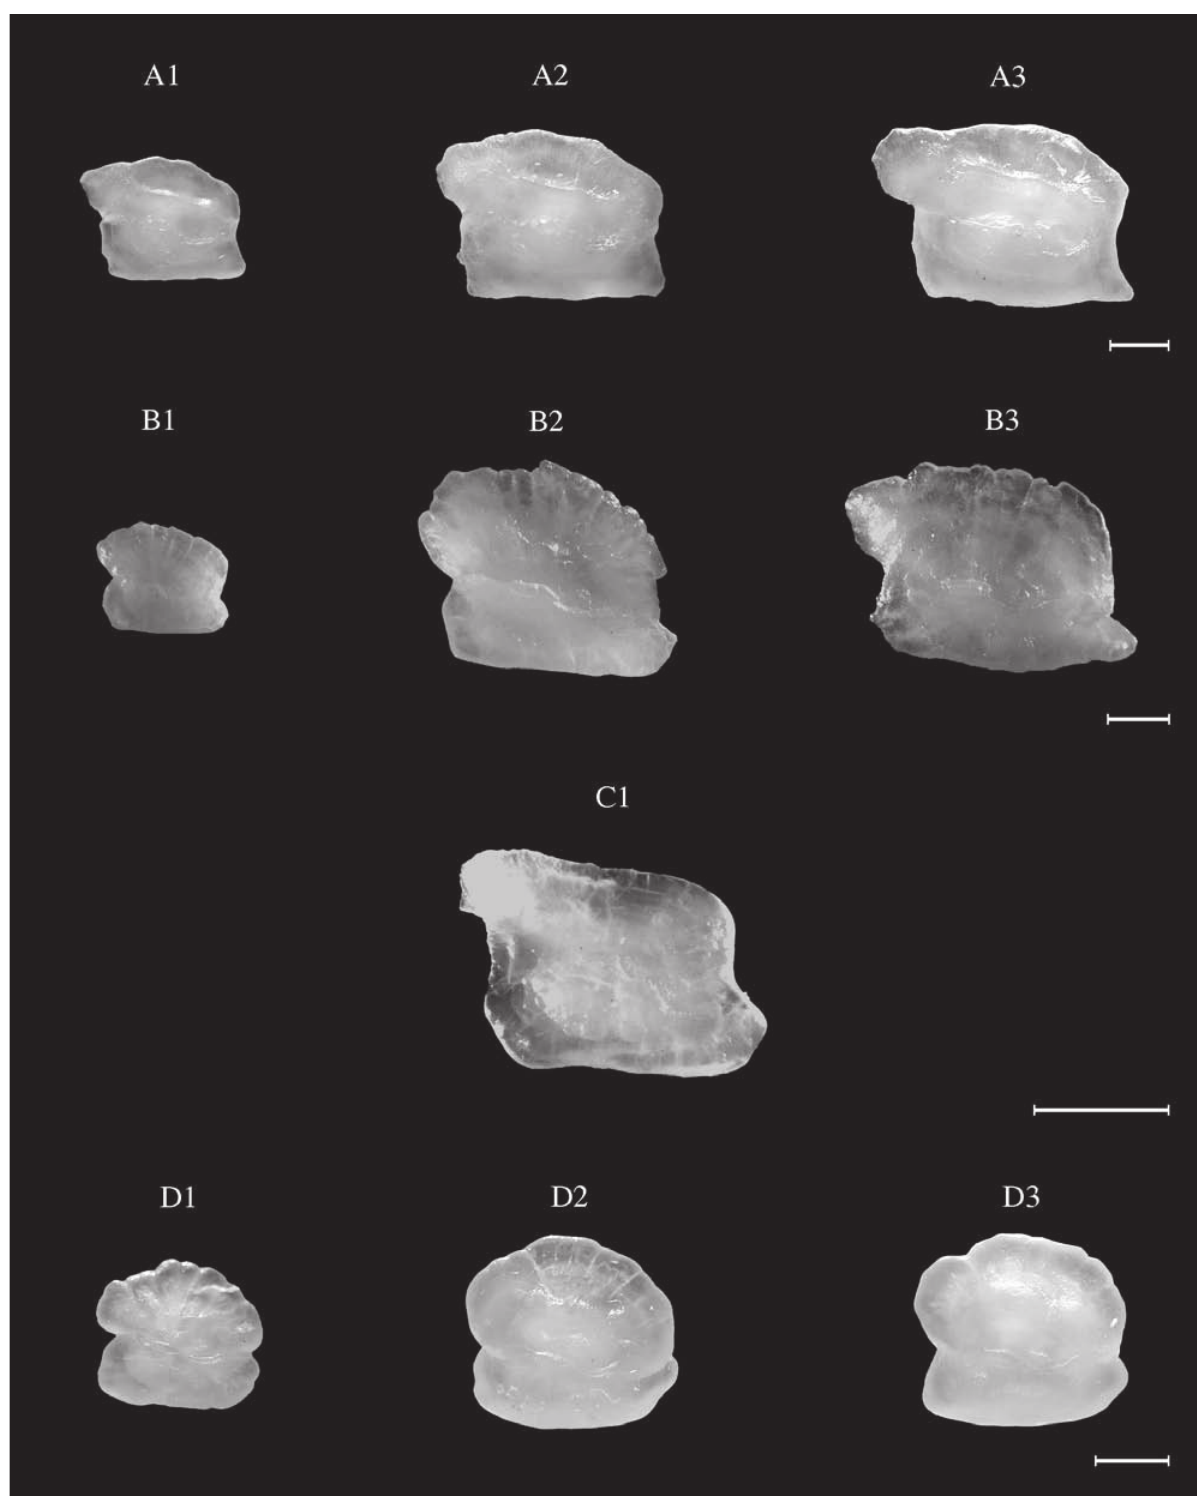
Fig. 80. – Gobius cruentatus (WM). TL: A1, 7.5 cm; A2, 11.0 cm; A3, 13.5 cm. Gobius niger . TL: B1, 6.0 cm (NEA); B2, 10.0 cm (WM); B3, 14.5 cm (NEA). Gobius paganellus (NEA). TL: C1, 7.9 cm. Lesueurigobius friesii (WM). TL: D1, 5.0 cm; D2, 6.5 cm; D3, 7.5 cm. Scale bar = 1